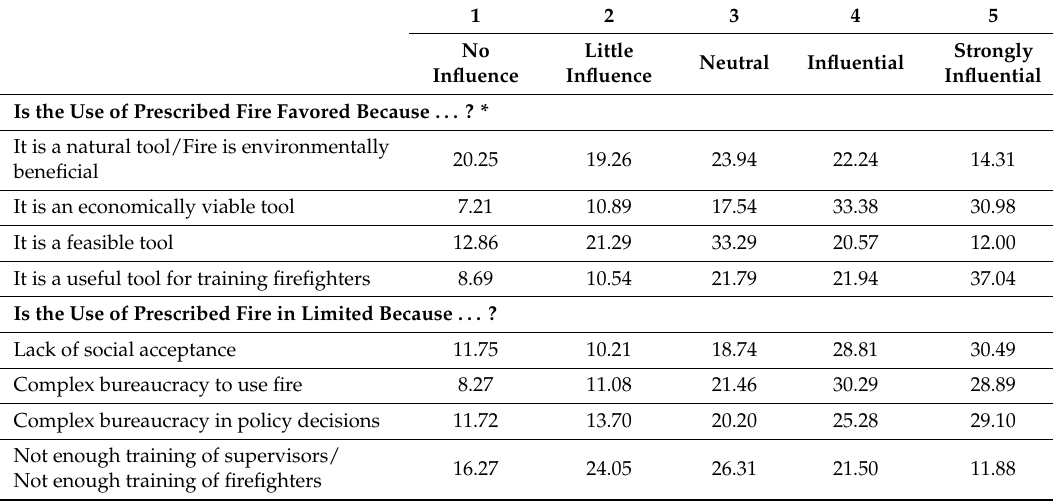
Table 3. Respondents’ perception of factors either limiting or favoring the use of fire for prevention purposes. Data displays perception of respondents (percentages of total, N = 726) on influence in the use of fire in